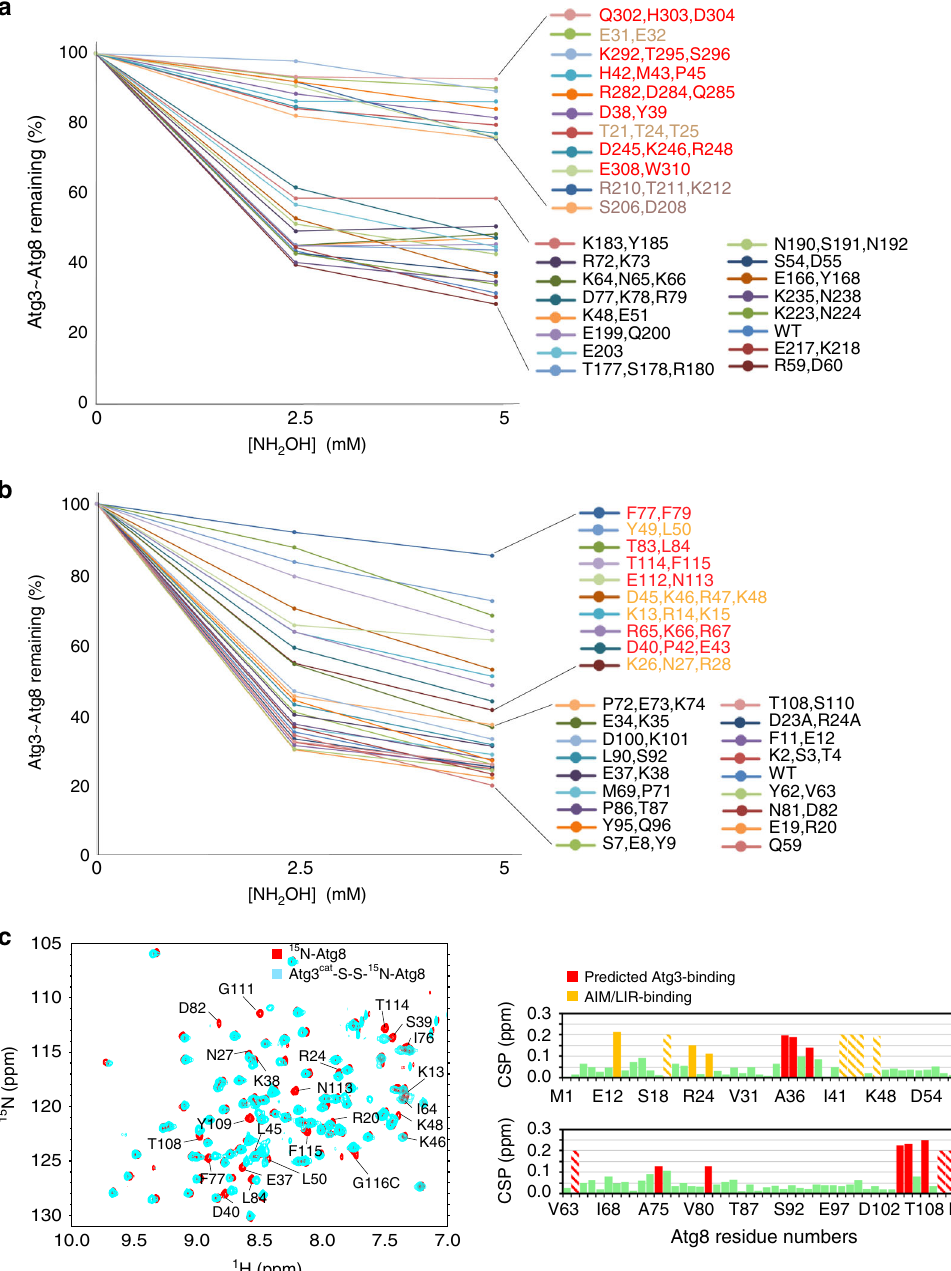
Fig. 7 Extensive surfaces of Atg8 and the Atg3 catalytic domain are required for activation of the Atg3~Atg8 intermediate. a E3-dependent activation of Atg3~Atg8 intermediate testing roles of indicated surfaces through multiple-Ala scanning mutagenesis over Atg3 ′ s catalytic domain. Quanti fi cation is of WT or indicated mutant versions of Atg3~Atg8 remaining after 2.5 min as a function of NH 2 OH concentration in pulse-chase assays, with Atg12 – Atg5- Atg16 as E3. b E3-dependent activation of Atg3~Atg8 intermediate testing roles of indicated surfaces through multiple-Ala scanning mutagenesis over Atg8, performed as in ( a ). c Effects of covalent Atg3 complex formation with Atg8, as detected by comparing 15 N, 1 H] TROSY spectra of 15 N-labeled Atg8 G116C (red) alone and disul fi de-bonded complex with Atg3 cat as a proxy for Atg3 cat – Atg8 intermediate (cyan), with chemical shift perturbations per Atg8 residue shown below. Stripes indicate resonances with line-broadening due to intermediate (Fig. 8a). Next, the locations of mutations impairing activity, and and the latter region is not fully visible in the crystal structures NMR chemical shift perturbations in the Atg3 cat – Atg8 complex, presumably due to potential to adopt different conformations. were analyzed, and found to be in striking concordance with the corresponding interface residues in canonical E2 – UB intermedi- ates (Fig. 8b, c, d). The notable exceptions were the AIM/LIR docking site in Atg8, Atg3 residues corresponding to E3-binding regions of canonical E2s, and the extreme C-terminus of Atg3. are consistent with roles in allosteric regulation. Indeed, in using These regions are not shared between Atg3 and canonical E2s, the Atg3 Δ FR crystal structure for the structural model, the